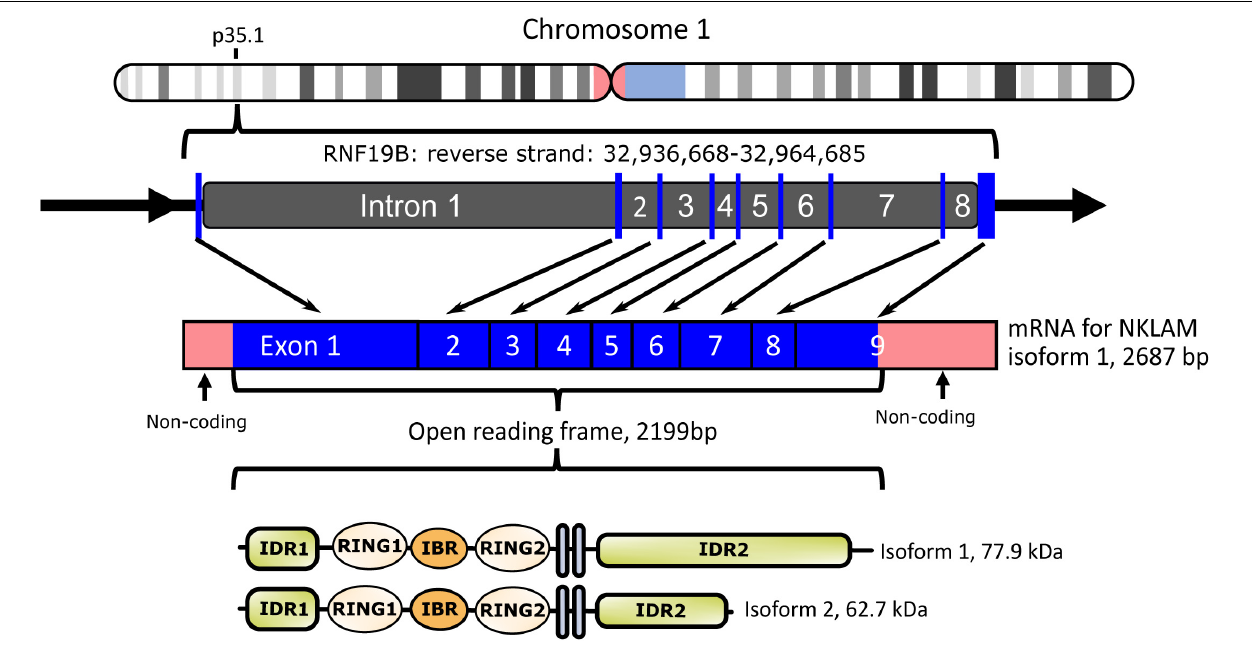
FIGURE 1 | Diagram of human NKLAM (RNF19B) gene organization. NKLAM is encoded by 9 exons (depicted as blue bars) spanning 28 kb in the reverse strand of chromosome 1. Exons 1–3 encode intrinsically disordered region 1 (IDR1) and the three RINGS of the ligase domain. Exons 4 and 5 encode the two transmembrane domains (gray bars), while IDR 2 is encoded across the remaining exons 6–9. Mouse NKLAM, located on chromosome 4, has the same genomic structure. Human NKLAM mRNA isoform 1 encodes a protein with a predicted molecular weight of 77.9 kDa. Alternative splicing of exon 9 results in a shorter mRNA isoform 2 encoding a protein with a predicted molecular weight of 62.7 kDa. Mice only express the long form of NKLAM protein.